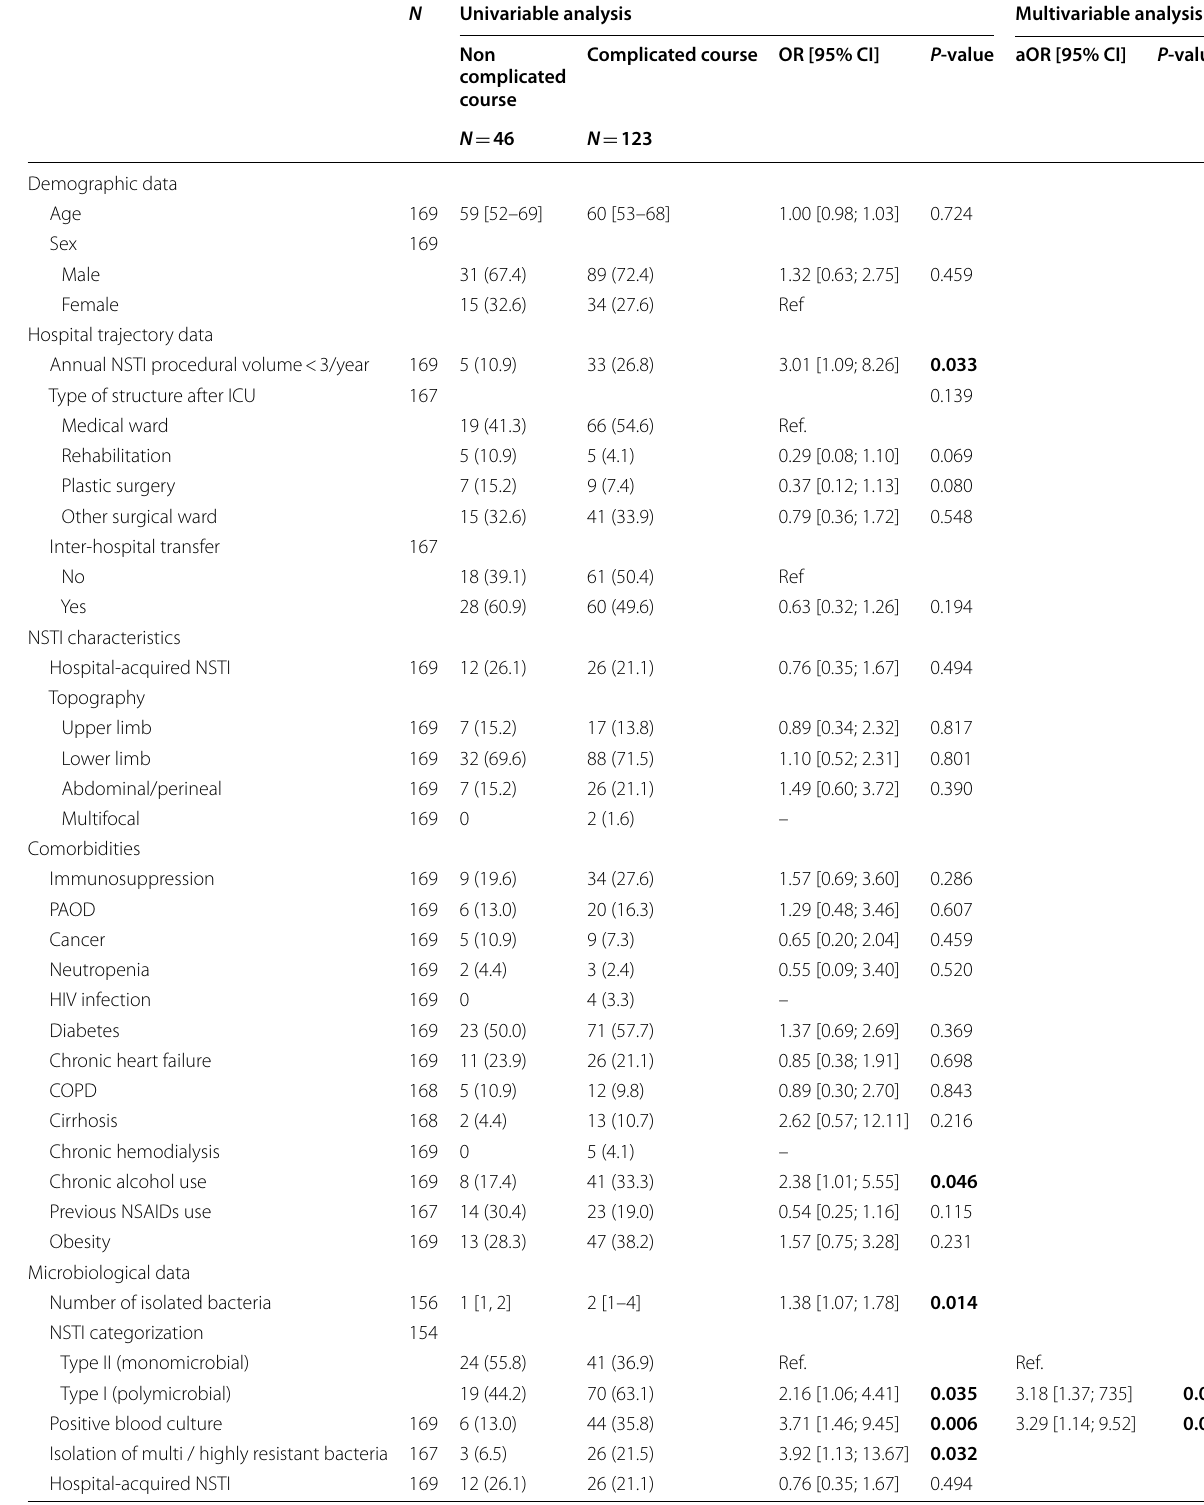
Table 3 Univariable and multivariable logistic regression analyses of factors associated with a complicated hospital course a